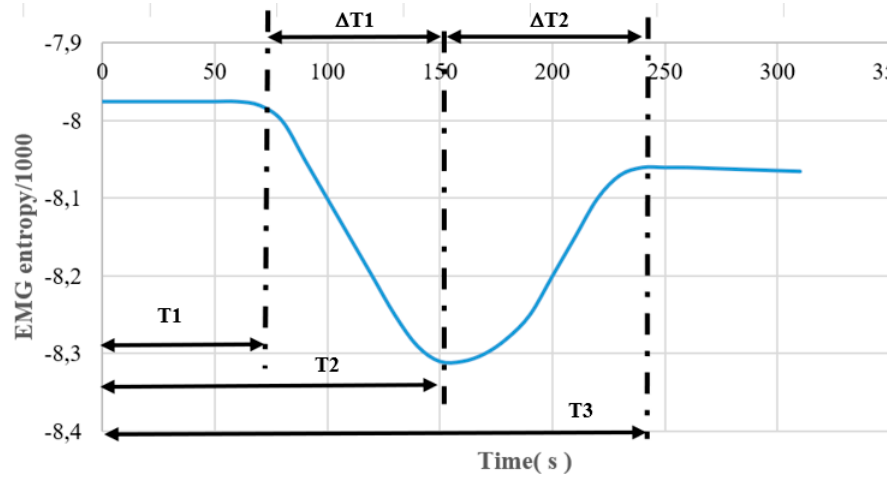
Figure 9. Positions of T1, T2, T3, ∆ T1, and ∆ T2.